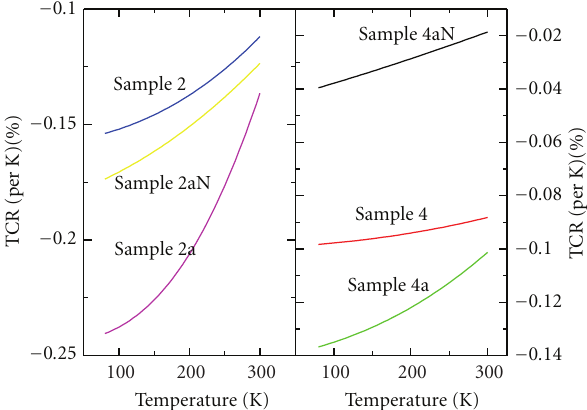
Figure 3: TCR ∼ T plots for as-prepared, annealed, and acid-treated one- and three-layered SWCNT